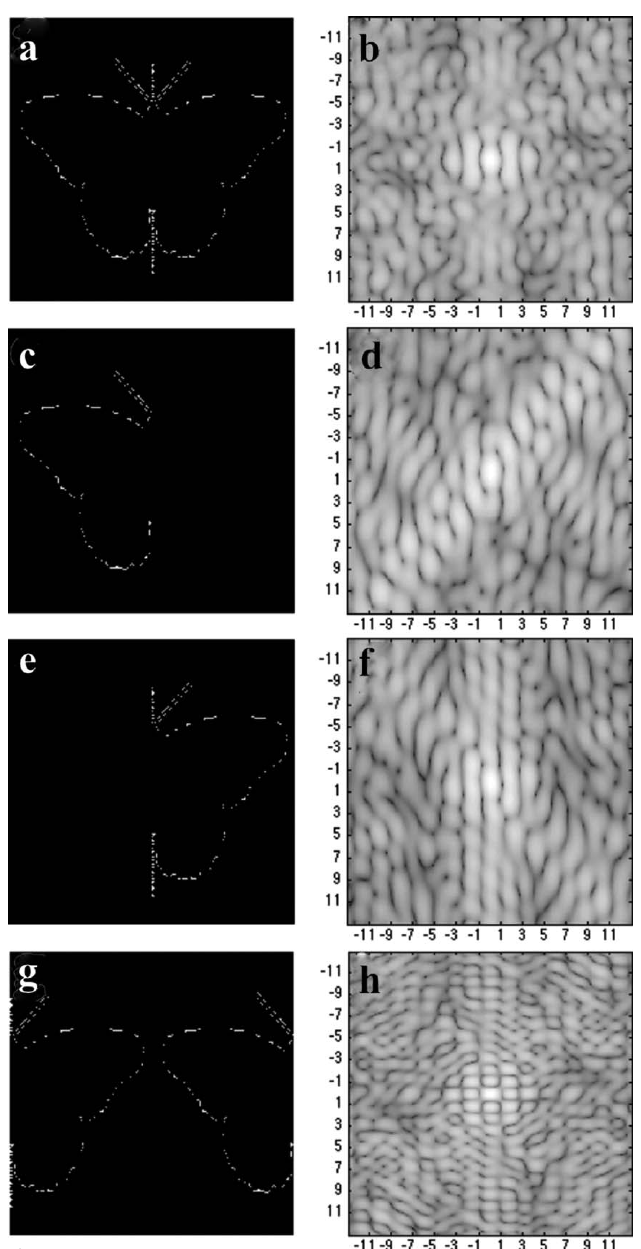
Figure 2 The images used in the simulations. The top row shows the default full unit cell and its scattering pattern. The two middle rows show the left and right half unit cells with their scattering patterns. The bottom row shows the swapped unit cell with its scattering pattern. For the images: the white pixels have density values of 1 and black are 0 (fully transmittive). The intensity is shown on a log-scale using a gray scale map. Axes are marked with the Miller